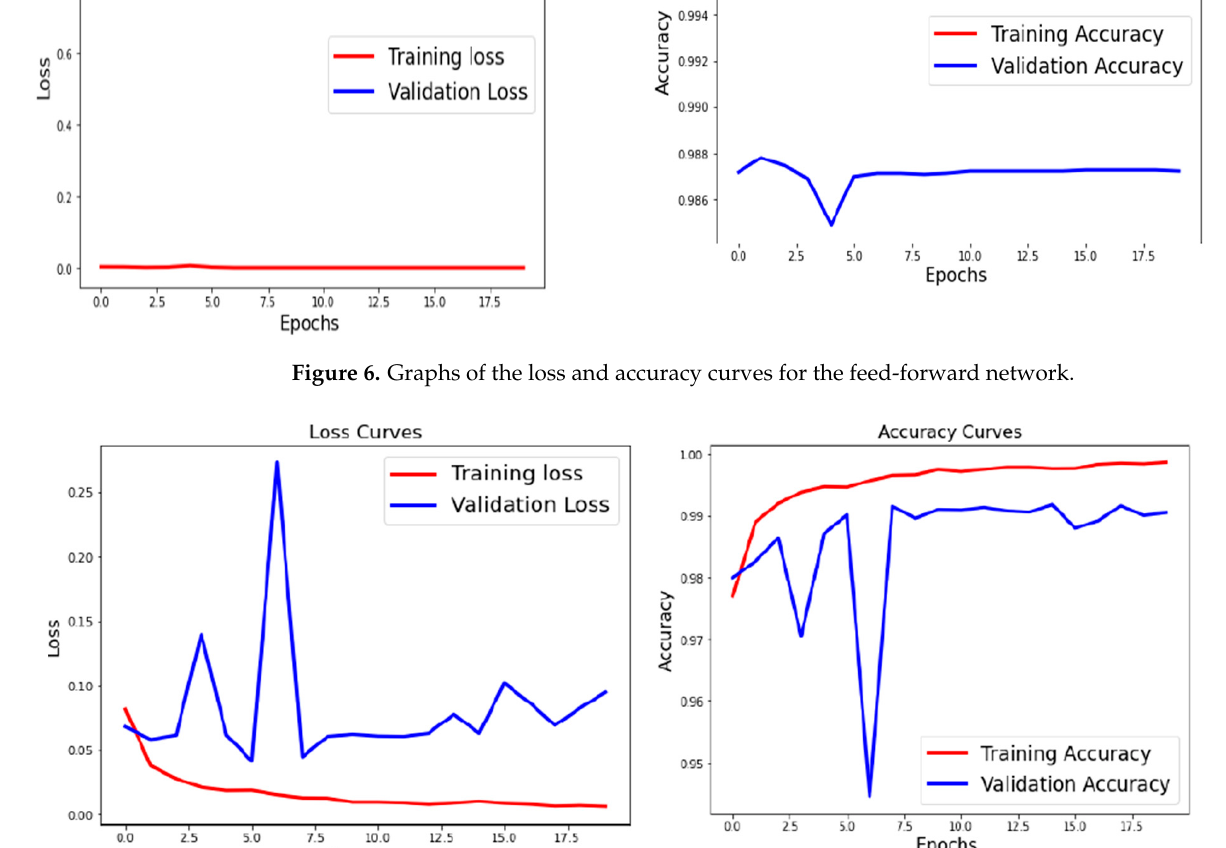
Figure 7. Graphs of loss and accuracy curves for the CNN.